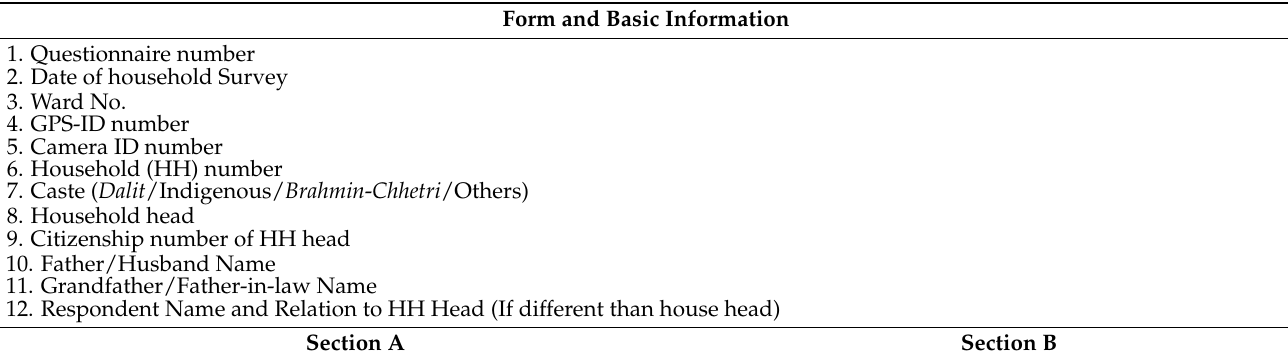
Table A2. Simplified Questionnaire (translated from Nepali